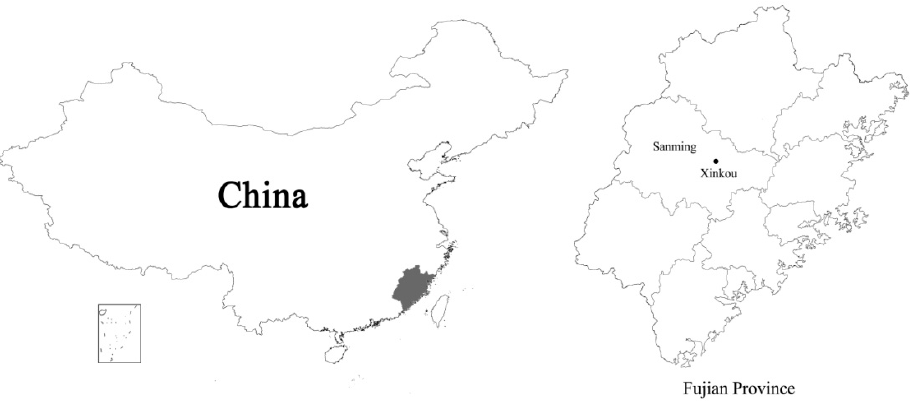
Figure 1. Location of the study area, Xinkou forest plantations, Sanming City, Fujian, China.